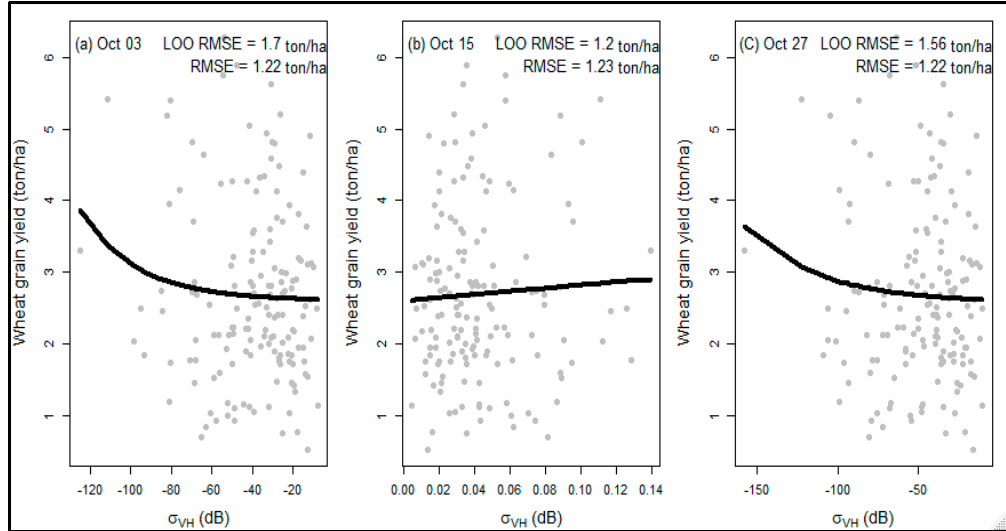
Figure 4. Scatter plots of SAR indices of single growth stage ( x − axis) and grain yield ( y − axis) for post ‐ grain ‐ filling stage.